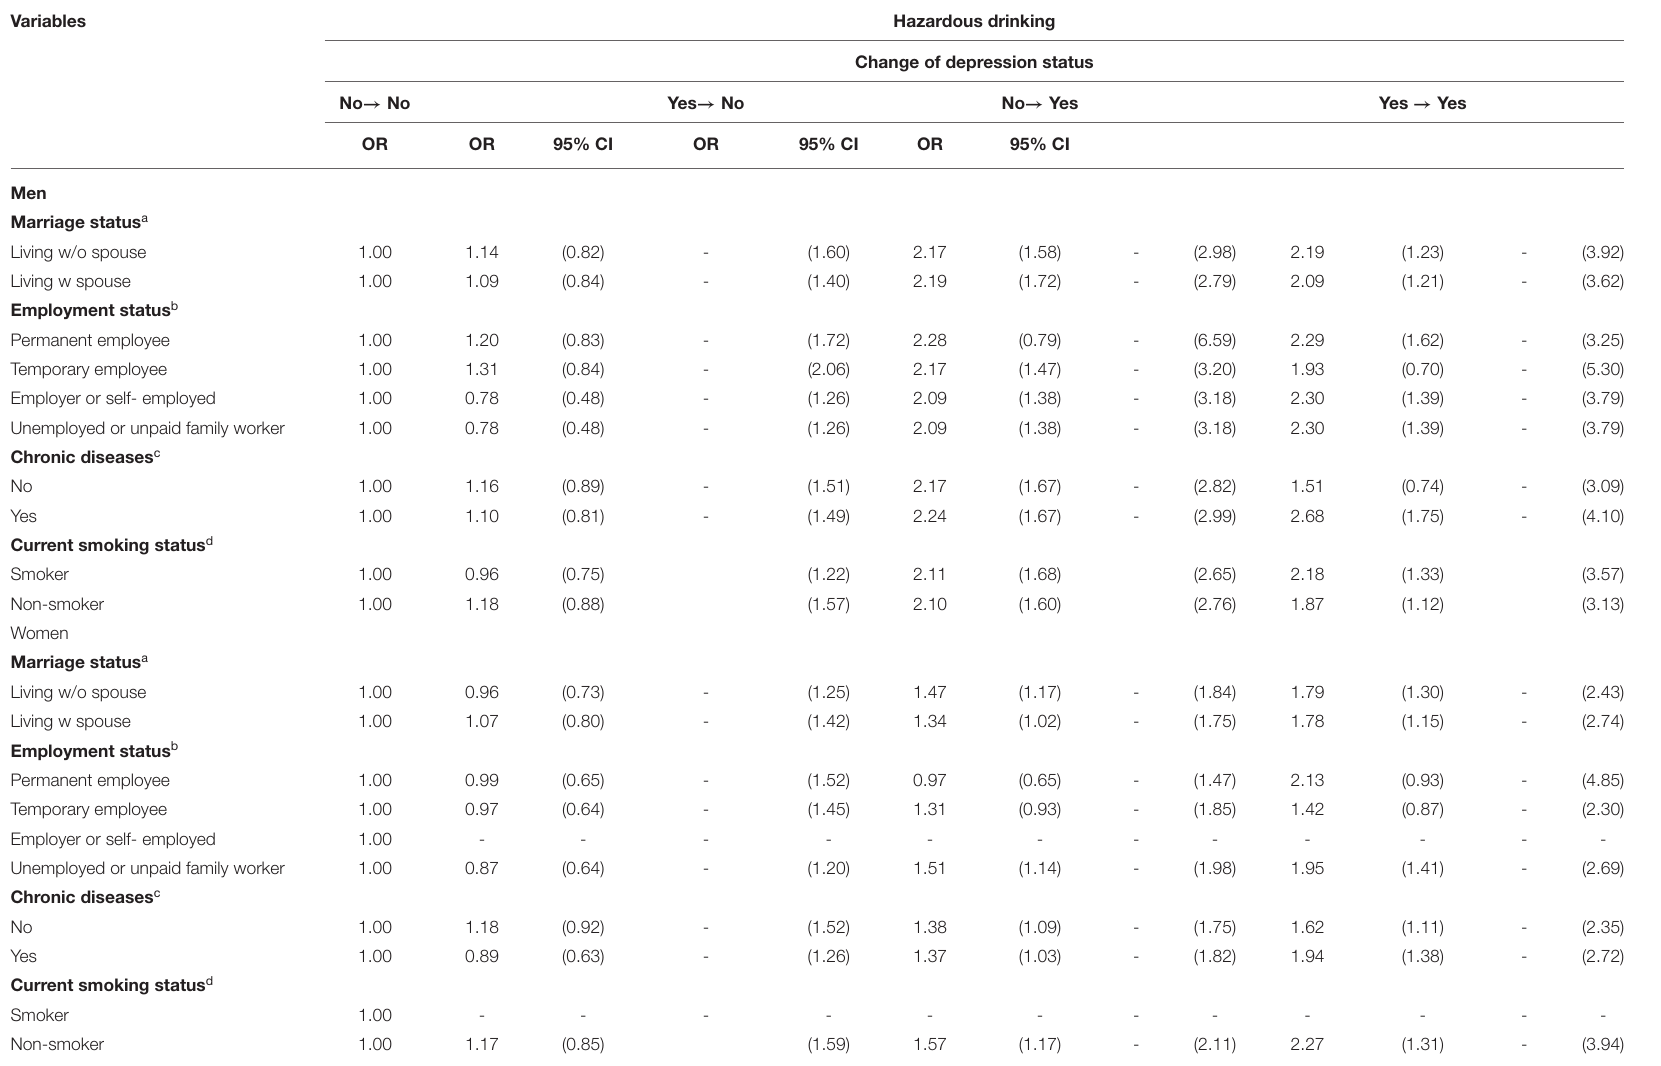
TABLE 3 | Subgroup analysis of the association between changes in depressive symptoms and hazardous drinking according to independent variables. Variables Hazardous drinking